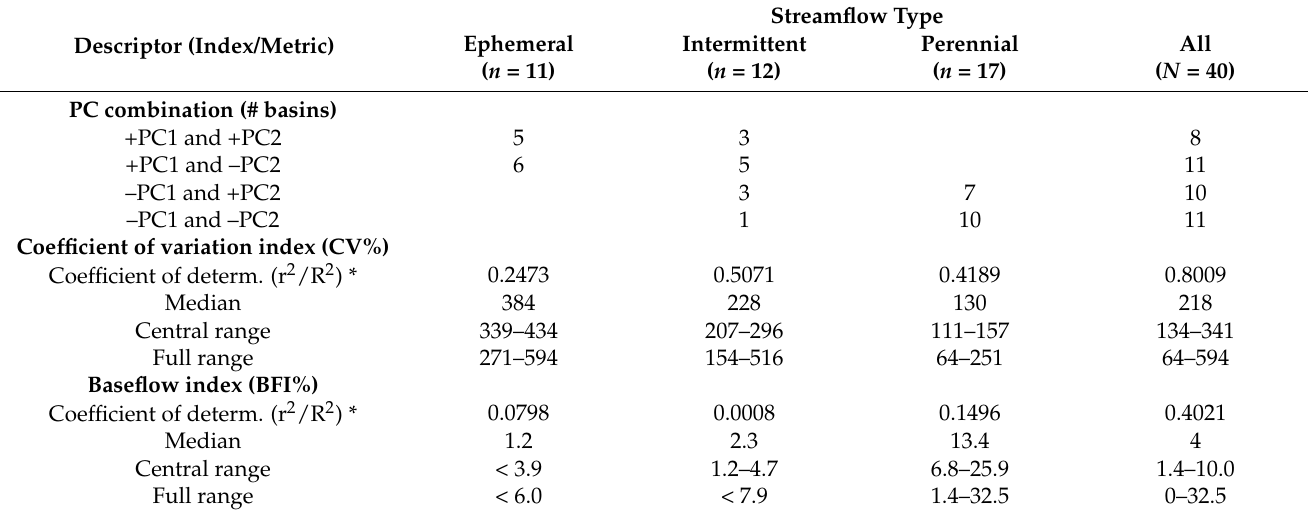
Table 2. Principal components combination (PC 1 and PC2), the coefficient of variation (CV%) and baseflow (BFI%) indices of hydrological variability, basin surface upstream from the river sites (km 2 ), and percentage of dominant climatic units per streamflow